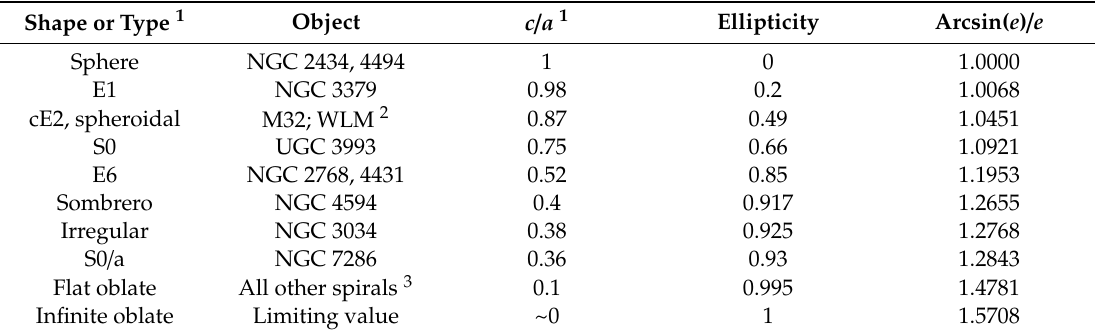
Table 3. Geometrical factors describing galactic